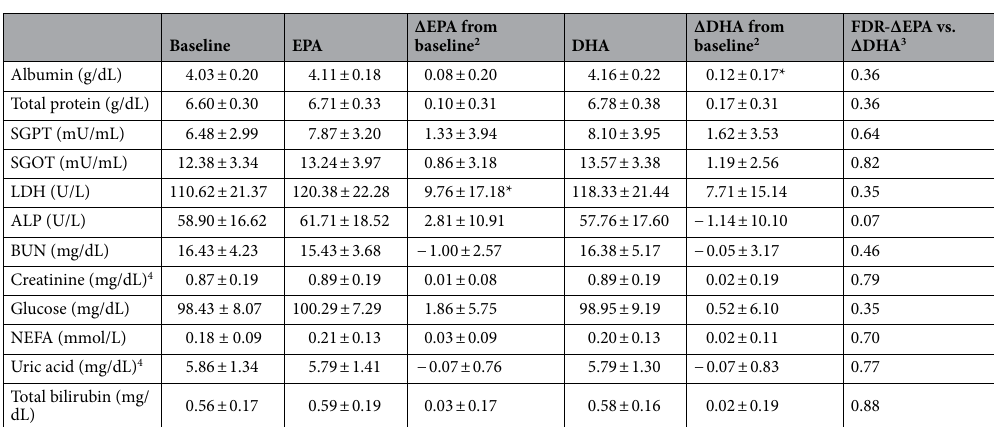
Table 2. Serum concentrations of biochemical parameters at baseline and after EPA and DHA supplementation 1 . 1 Values are reported as unadjusted mean ± SD. To correct for skewed distribution, log- transformation was applied before analysis. 2 Comparison of changes from baseline to EPA or DHA was